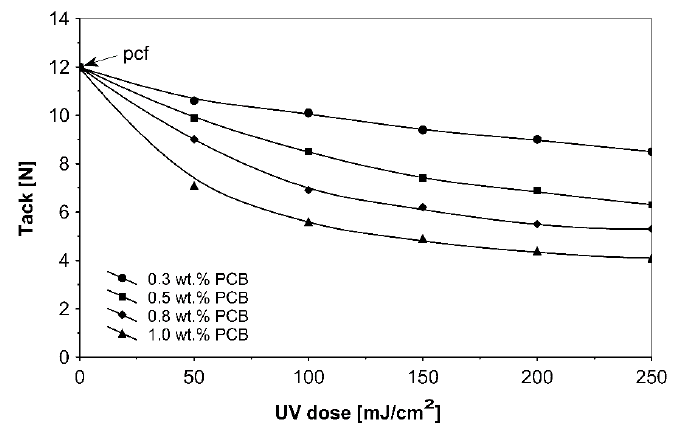
Figure 8. Tack of UV-crosslinked acrylic PSAs containing various amounts of additionable photoinitiator versus UV dose.